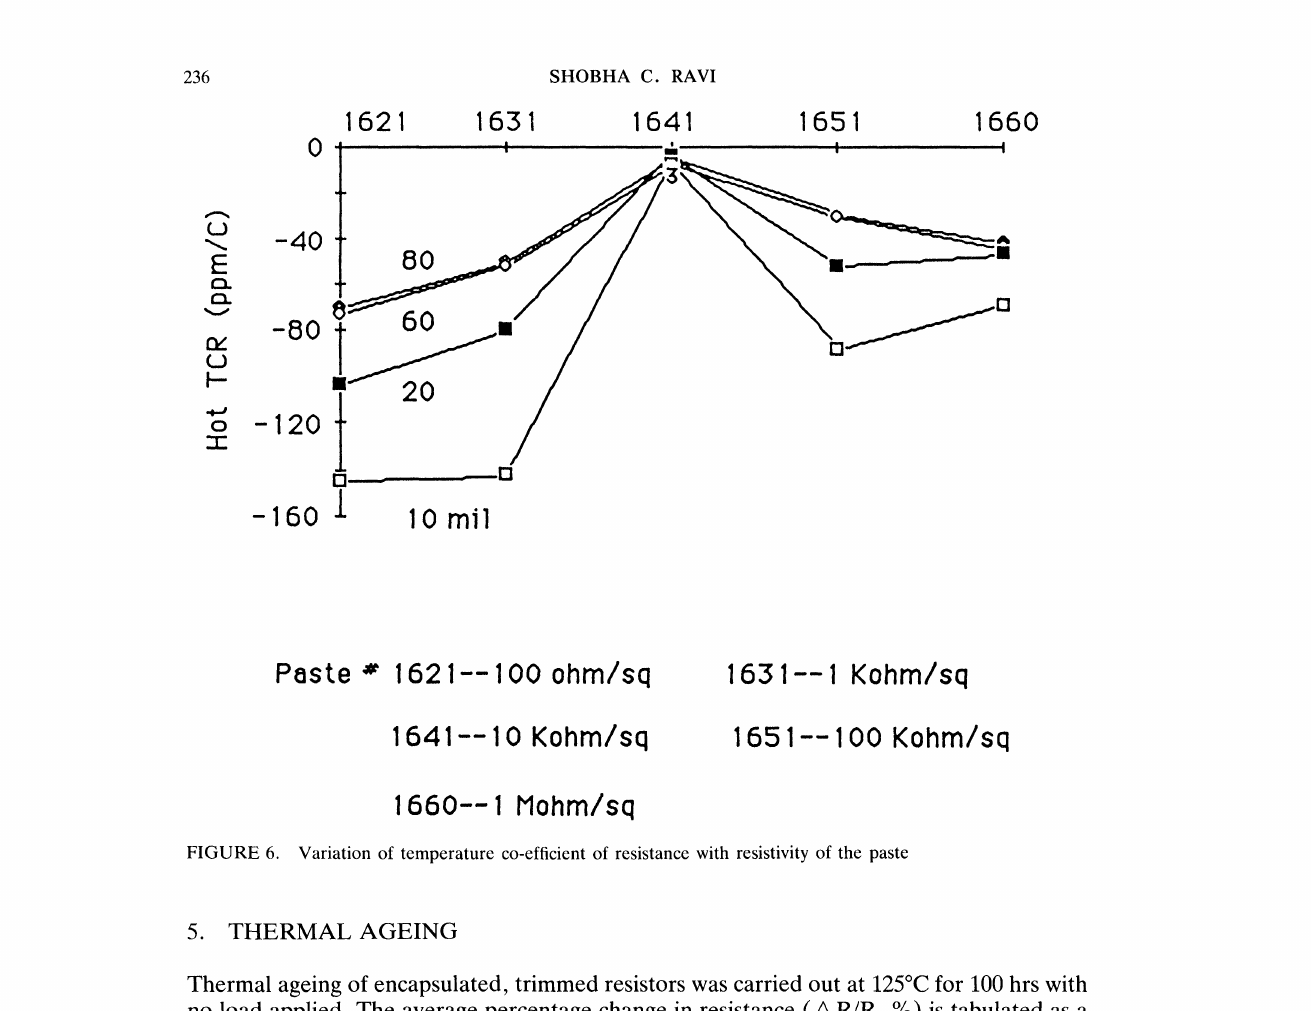
TABLE III Thermal ageing @ 125 C for 100